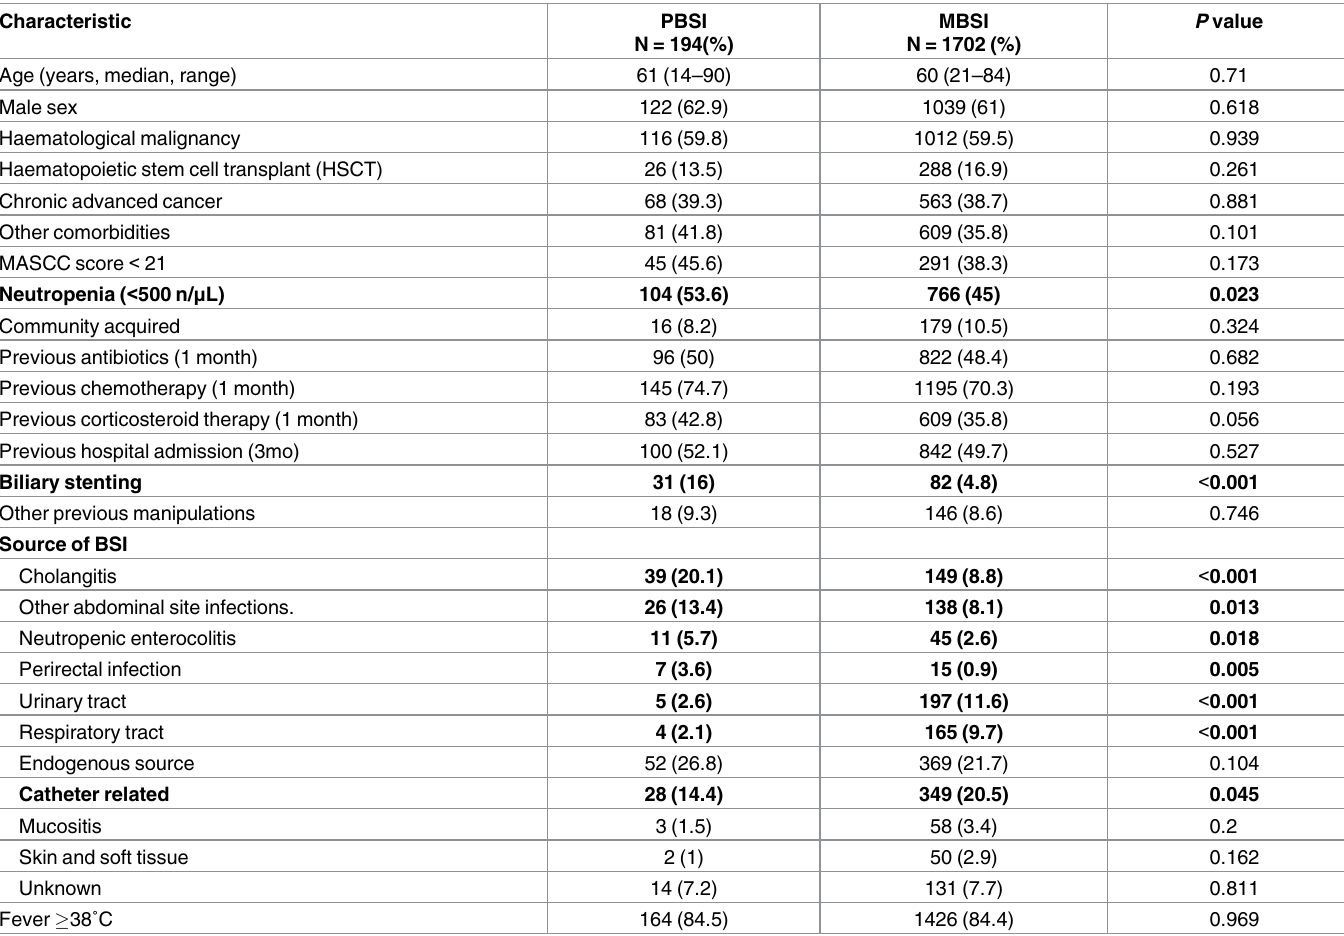
Table 1. Baseline characteristics and clinical presentation in patients with polymicrobial bloodstream infection and monomicrobial bloodstream infection. Characteristic